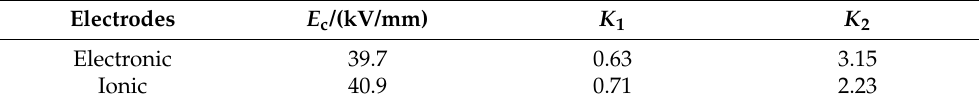
Table 2. Critical point E c , and nonlinear coefficients K 1 and K 2 under the applied electric fields lower and higher than E c , respectively, for J – E curves tested with i-electrode and